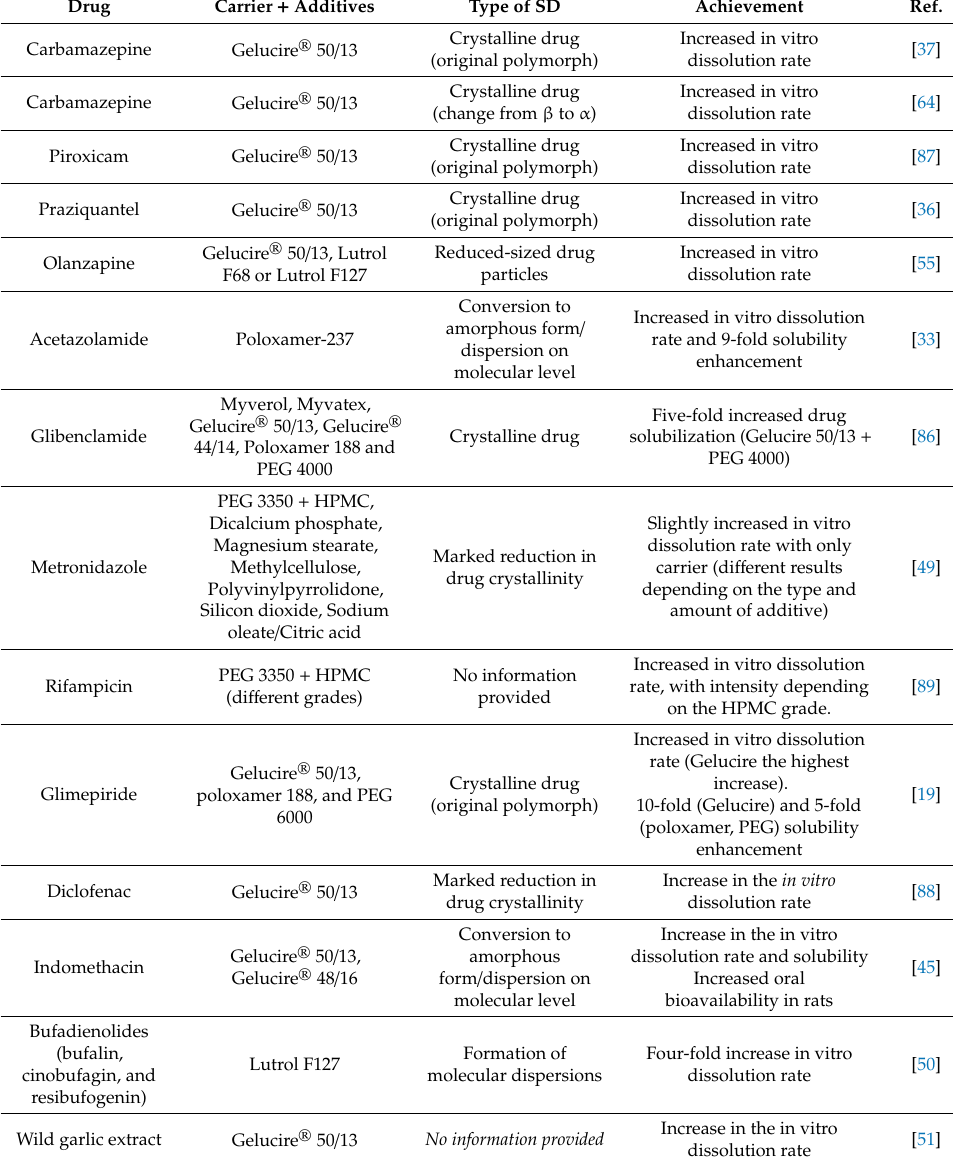
Table 1. Application of spray congealing to oral bioavailability enhancement of poorly water soluble drugs used without